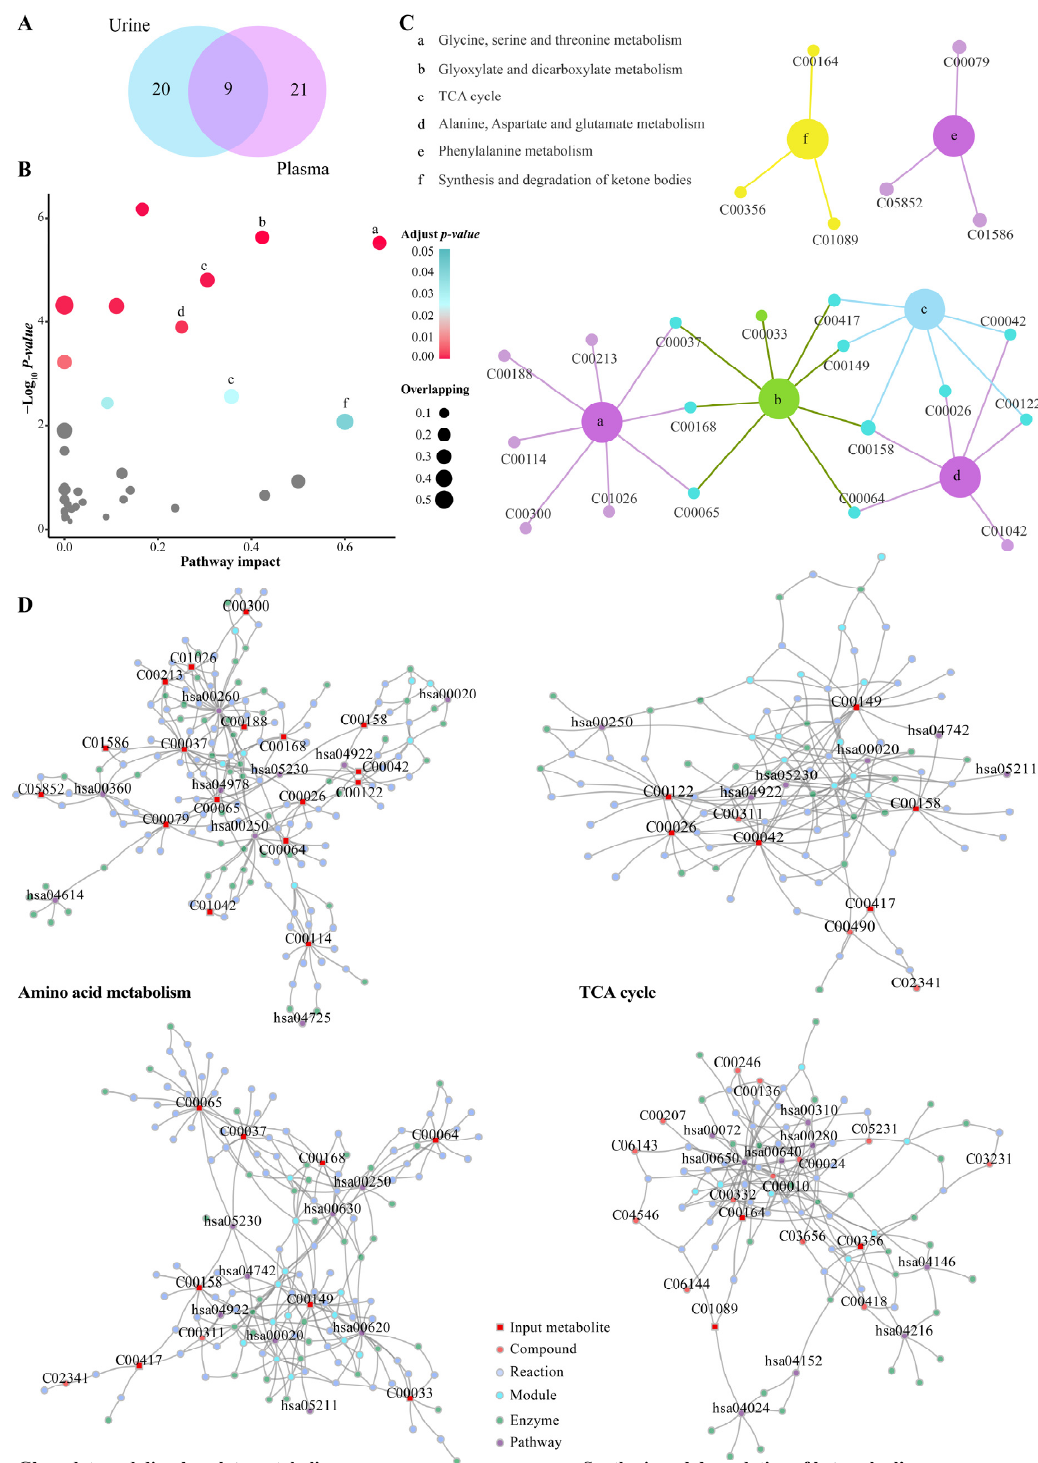
Figure 7. Pathway analysis and network diffusion analysis of differential metabolites. ( A ) Venn diagram of selected differential metabolites in urine and plasma. ( B ) Pathway analysis results of the Metabo- Analyst tools. The grey points indicate no significantly enriched pathway (adjusted p values > 0.05); the points of light blue to red indicate significantly enriched pathways (adjusted p values < 0.05); the size of the points indicates the number of overlapping metabolites in the pathway. ( C ) Plot showing the relevant differential metabolites contained in significantly enriched pathways. ( D ) Significantly enriched pathway-related metabolite–enzyme–reaction–module–pathway